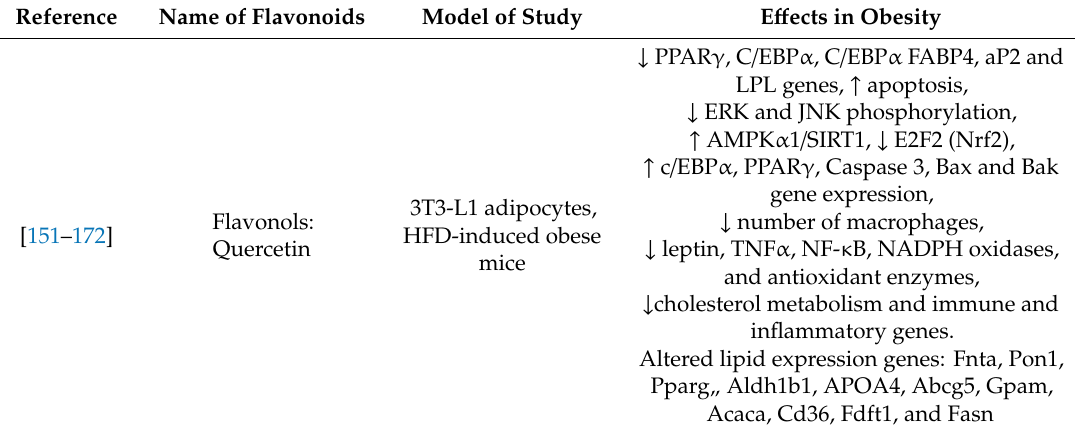
Table 2. Summary of flavonoids e ff ects on adipocytes and adipose tissue related with obesity ( ↓ = decreased, ↑ =